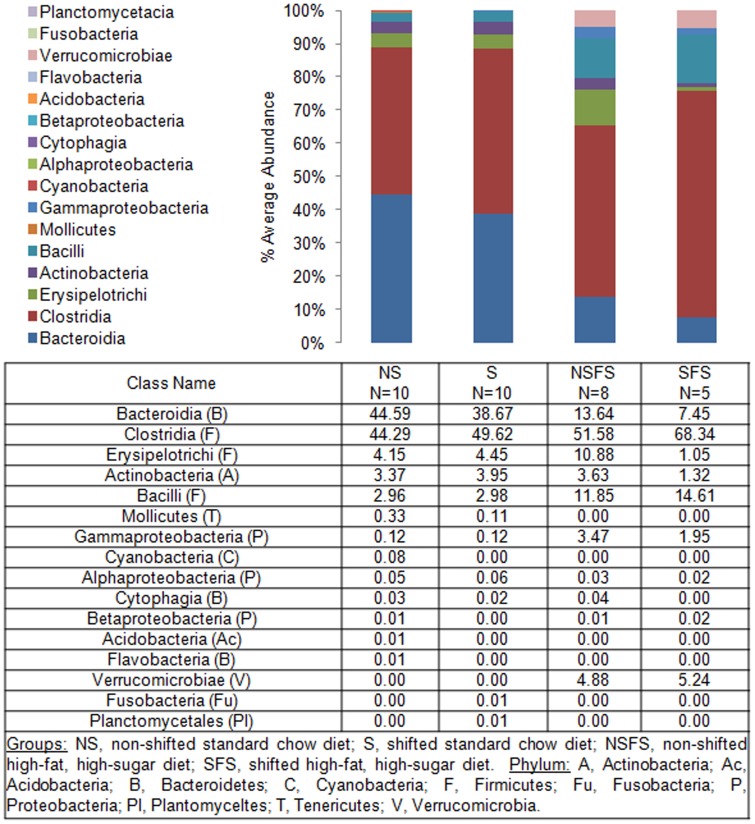
Mouse gut microbial community structure at the class level.The bar graph graphically represents the average relative abundance of classified bacteria SSU rRNA gene amplicons belonging to the most abundant taxon at the class level.